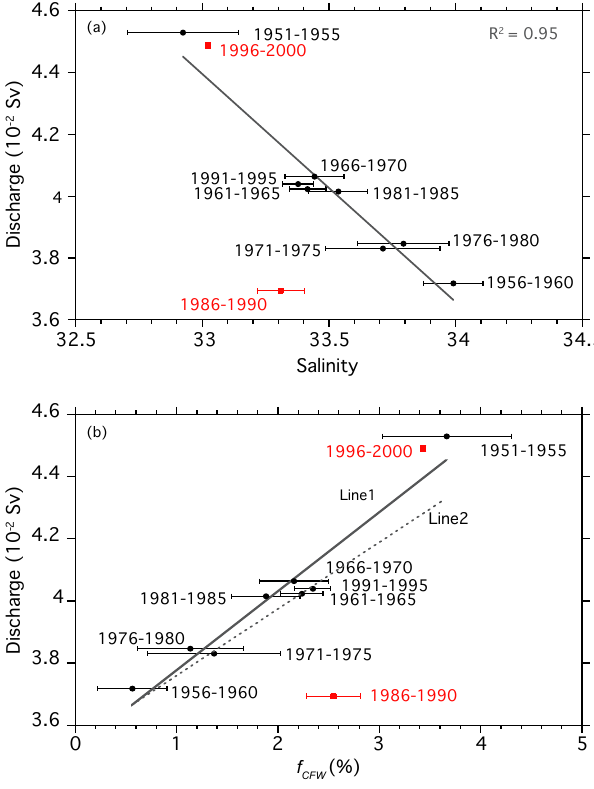
Figure 10. (a) Modern relationship between 5-year-mean salin- ity (July–August) around site KY and freshwater discharge of the Changjiang. Comparison of 5-year-mean wet season (May– October) Changjiang discharge at Datong station from 1951 to 2000, showing the robust relationship between them. Bars associ- ated with black filled circles represent σ 2 of the annual mean for the 5-year interval. Original salinity data were collected with a Nansen bottle water sampler, and the MBT, CTD, and XBT measurements were downloaded for the area of 31 ◦ –32 ◦ N, 128 ◦ –129 ◦ E from an online archive (http://www.jodc.go.jp/jodcweb/JDOSS/index_j. html). These salinity data were annually averaged from the depth of 0 to 30m, and further averaged every 5-year interval from 1951 to 2000. (b) Comparison of 5-year-mean wet season (May to October) Changjiang discharge at Datong station with 5-year-mean relative contribution of Changjiang freshwater ( f CFW ) in the northern ECS derived from observational salinity data (31 ◦ –32 ◦ N, 128 ◦ –129 ◦ E). The 5-year-mean data in the time interval from 1986 to 1990 and 1996–2000 are omitted (red